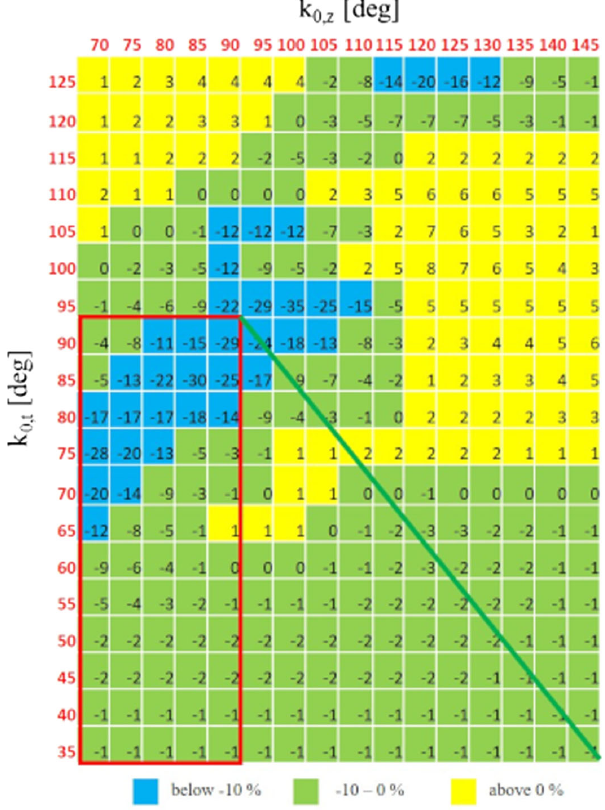
FIG. 5. Relative longitudinal rms-emittance growth for zero current phase advances of 35 ° ≤ k 0 ;t ≤ 125 ° and 70 ° ≤ k 0 ;z ≤ 145 ° along the first cavity of the DTL for a proton beam of 2.0 mA. Blue cells indicate emittance below − 10% , green cells − 10% – 0% , and yellow cells 0% – 10%. The red framed zone marks the conventional “ safe ” design rule below 90°. An extended safe region for all values k 0 ;z > 90 ° is identified as long as k 0 ;t ≤ 90 °. The absence of noticeable emittance growth above the green diagonal line indicates that the theoretically possible sum resonance of Ref. [12] is insignificant for this short lattice.